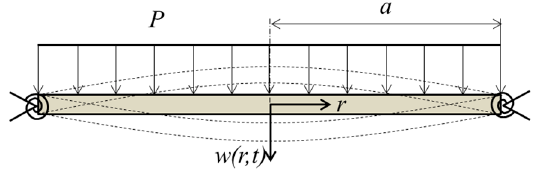
Figure 2. Theoretical vibration model of the varifocal mirror.